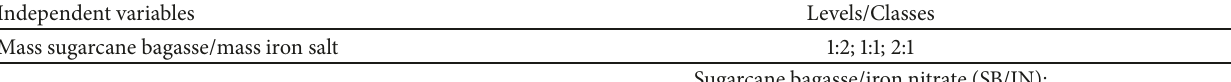
Table 1: Factors(independent variables) and their respective levels (or classes) chosenin the optimization stage of the composite production. Independent